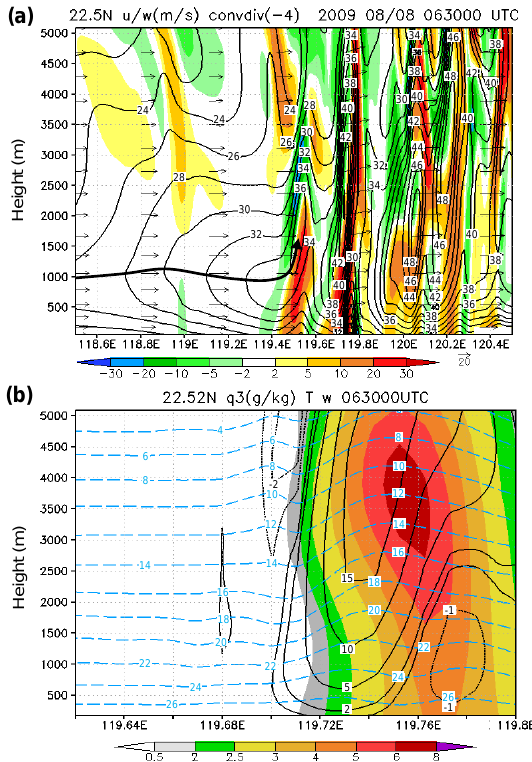
Figure 10. E–W vertical cross sections, through cell A1, of model- simulated (a) wind vectors on the section plane (ms − 1 , reference vector at bottom), and horizontal wind speed (ms − 1 , isotachs, ev- ery 2ms − 1 ) and convergence/divergence (10 − 4 s − 1 , color, scale at bottom, positive for convergence) along 22.5 ◦ N from 118.5 to 120.5 ◦ E (about 200km in length), and (b) vertical velocity (ms − 1 , contours, at ± 1, ± 2, ± 5, ± 10, and ± 15ms − 1 , dotted for down- ward motion), temperature ( ◦ C, dashed cyan isotherms, every 2 ◦ C), and mixing ratio of total precipitation (gkg − 1 , color, scale at bot- tom), along 22.52 ◦ N from 119.62 to 119.8 ◦ E (about 18km in length) at 06:30UTC, 8 August 2009. The thick arrow-line in (a) marks the axis of LLJ in the background flow.